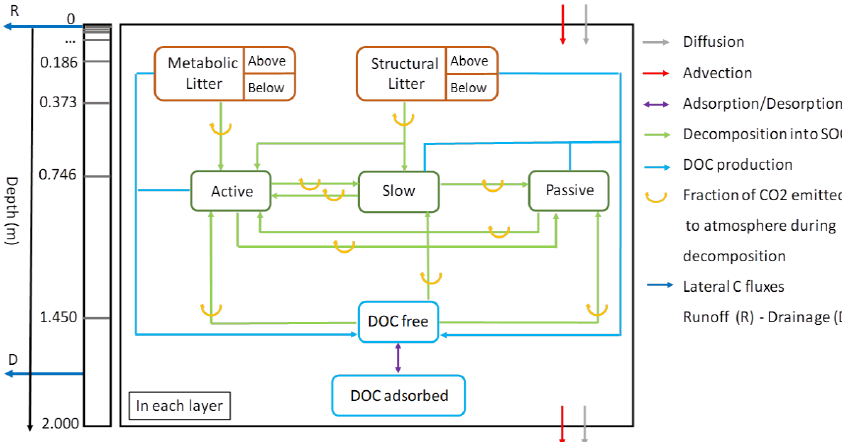
Figure 1. The new version of the soil module of ORCHIDEE-SOM. The left box represents the discretization of the soil column and the transport processes between layers. The right box shows an overview of all the biogeochemical transformation processes that occur in each